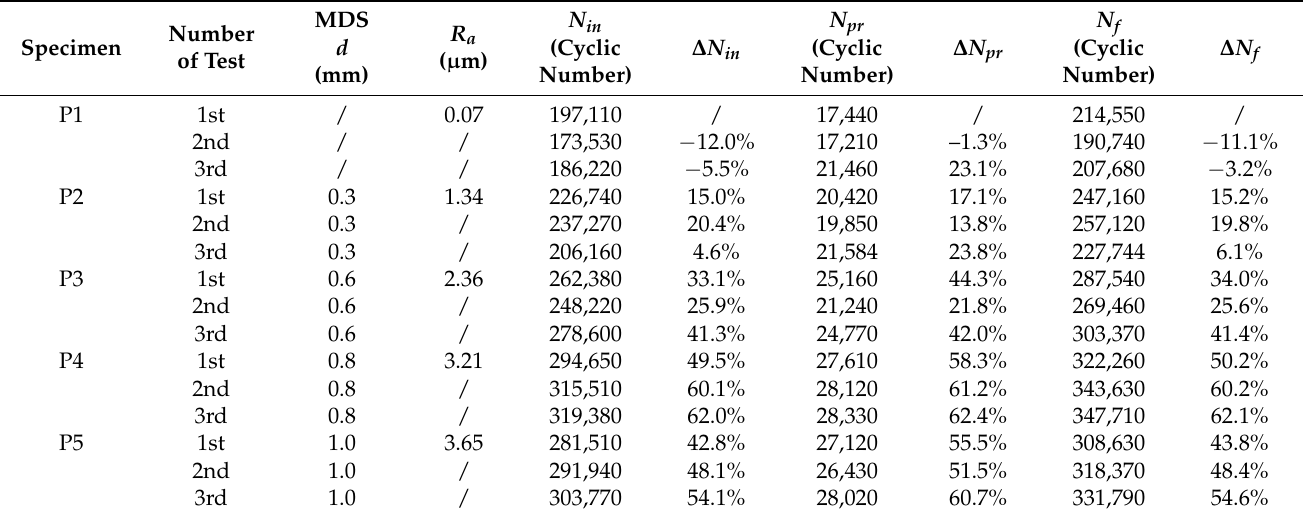
Table 4. Fatigue lives of ship hatch corner